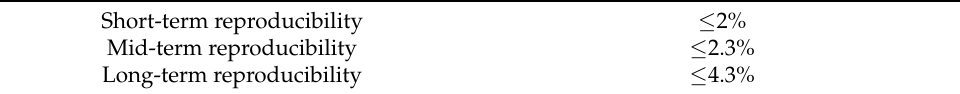
Table 1. Short-, mid-, and long-term reproducibility expressed as percentage variations of the detector sensitivities for the whole set of measurements.